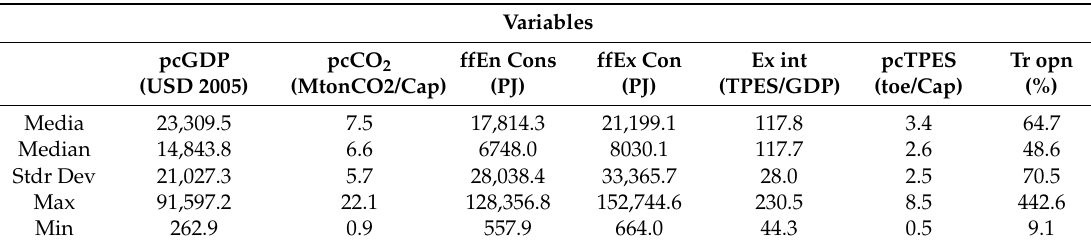
Table 5. Summary of empiric results of the multivariable framework.